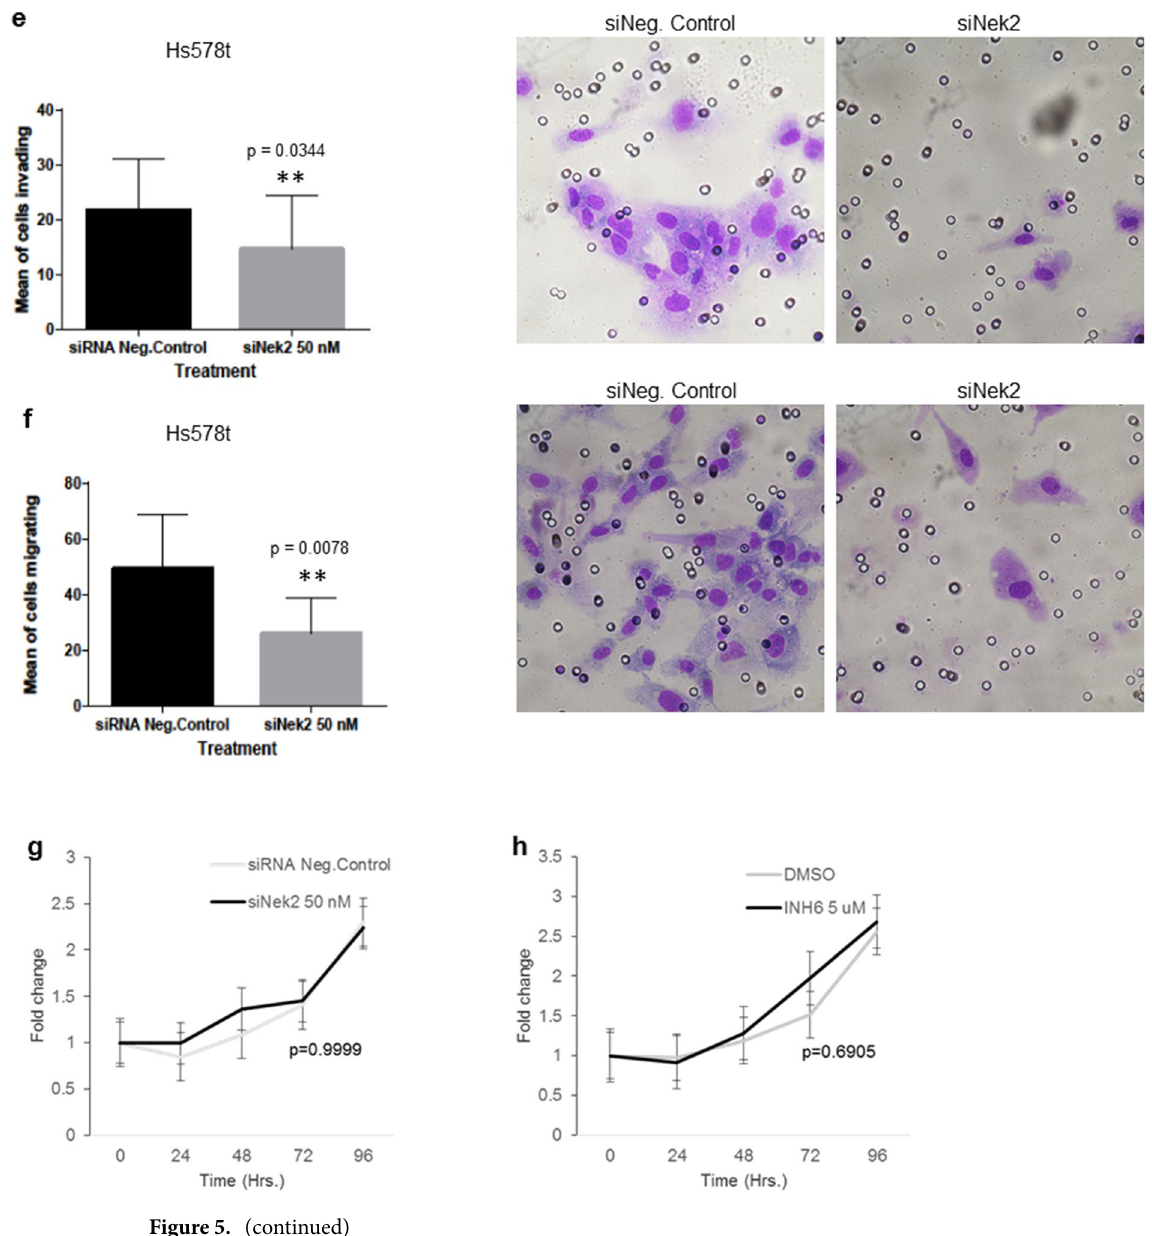
Figure 5. Slug and Zeb1 are involved in the invasion and migration of triple‑negative breast cancer cells. Figure 4 and Suppl. Fig. 6 indicated downregulation of Slug and Zeb1 protein levels. To find additional mechanisms driving EMT, we screened several genes coding for EMT structural proteins, as well as EMT tran- scription factors by qRT-PCR. In MDA-MB-231 cells, Nek2 inhibition by INH6 reduced the β-catenin and Slug mRNA levels compared with control (Fig. 6a). In Hs578t, Nek2 inhibition resulted not only in reduced mRNA levels of β-catenin and Slug but also of the Zeb1 and Zeb2 EMT transcription factors (Fig. 6b). In MDA-MB-231 cells, Slug siRNA significantly reduced invasion (Fig. 6c) and migration (Fig. 6g), while Zeb1 siRNA reduced invasion (Fig. 6d) without significantly affecting migration (Fig. 6h). In Hs578t cells, Slug siRNA significantly decreased cell migration (Fig. 6i) without significantly affecting invasion (Fig. 6e), whereas Zeb1 siRNA signifi- cantly reduced both invasion (Fig. 6f) and migration (Fig. 6j) relative to control.